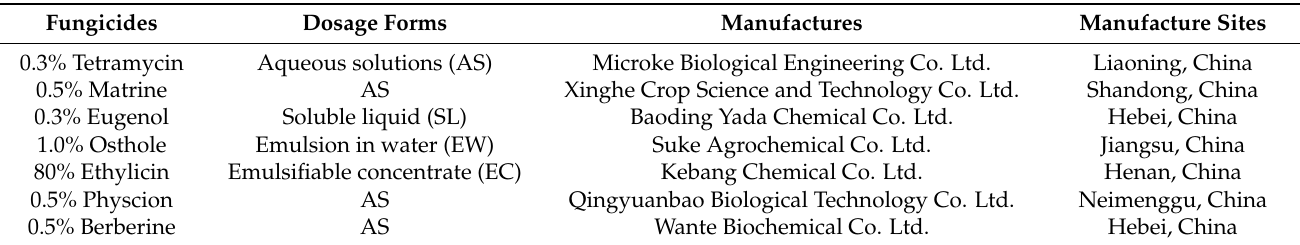
Table 1. Information of tetramycin and botanical